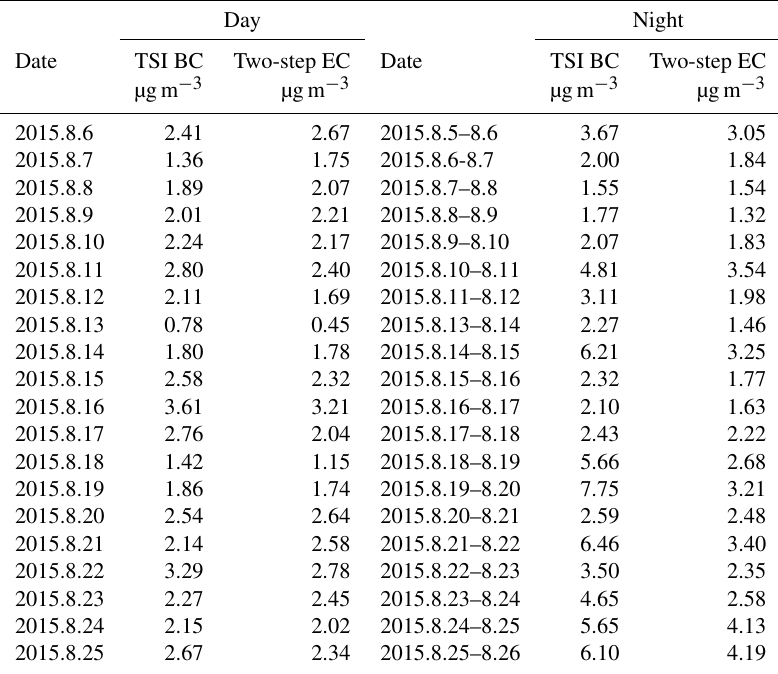
Table 3. Statistics of BC and EC concentrations in atmospheric samples measured using the TSI and two-step thermal–optical methods. Day Night Date TSI BC Two-step